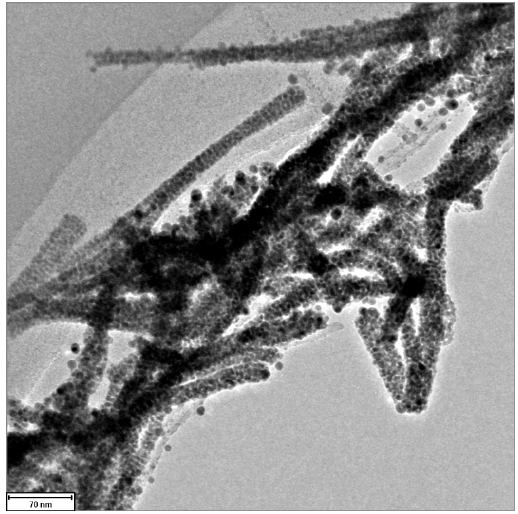
Figure 4. TEM micrograph of the distribution image of AgNPs attached on the CNTs.